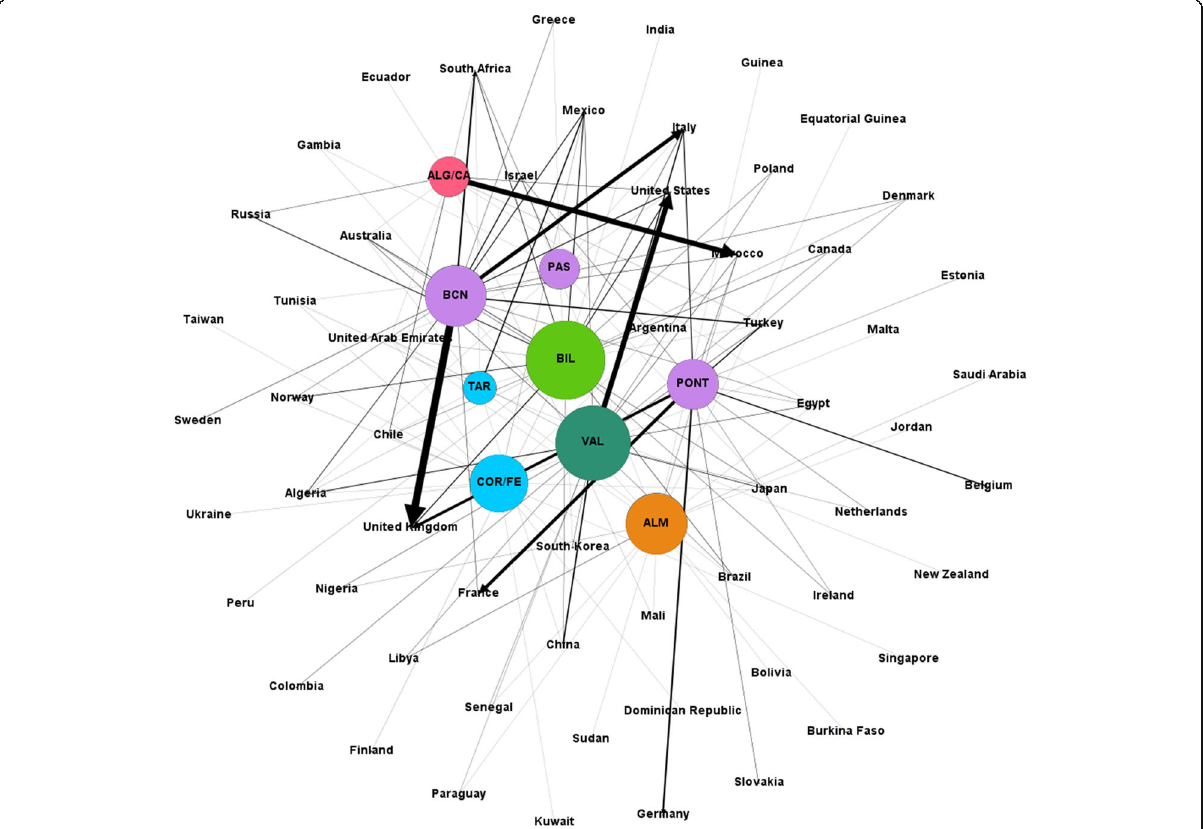
Fig. 2 Main export links for automobiles and their parts in 2019. Nodes and arrows are proportional to the degree of the node and the weight of the link respectively. Nodes in the same community are represented with the same color